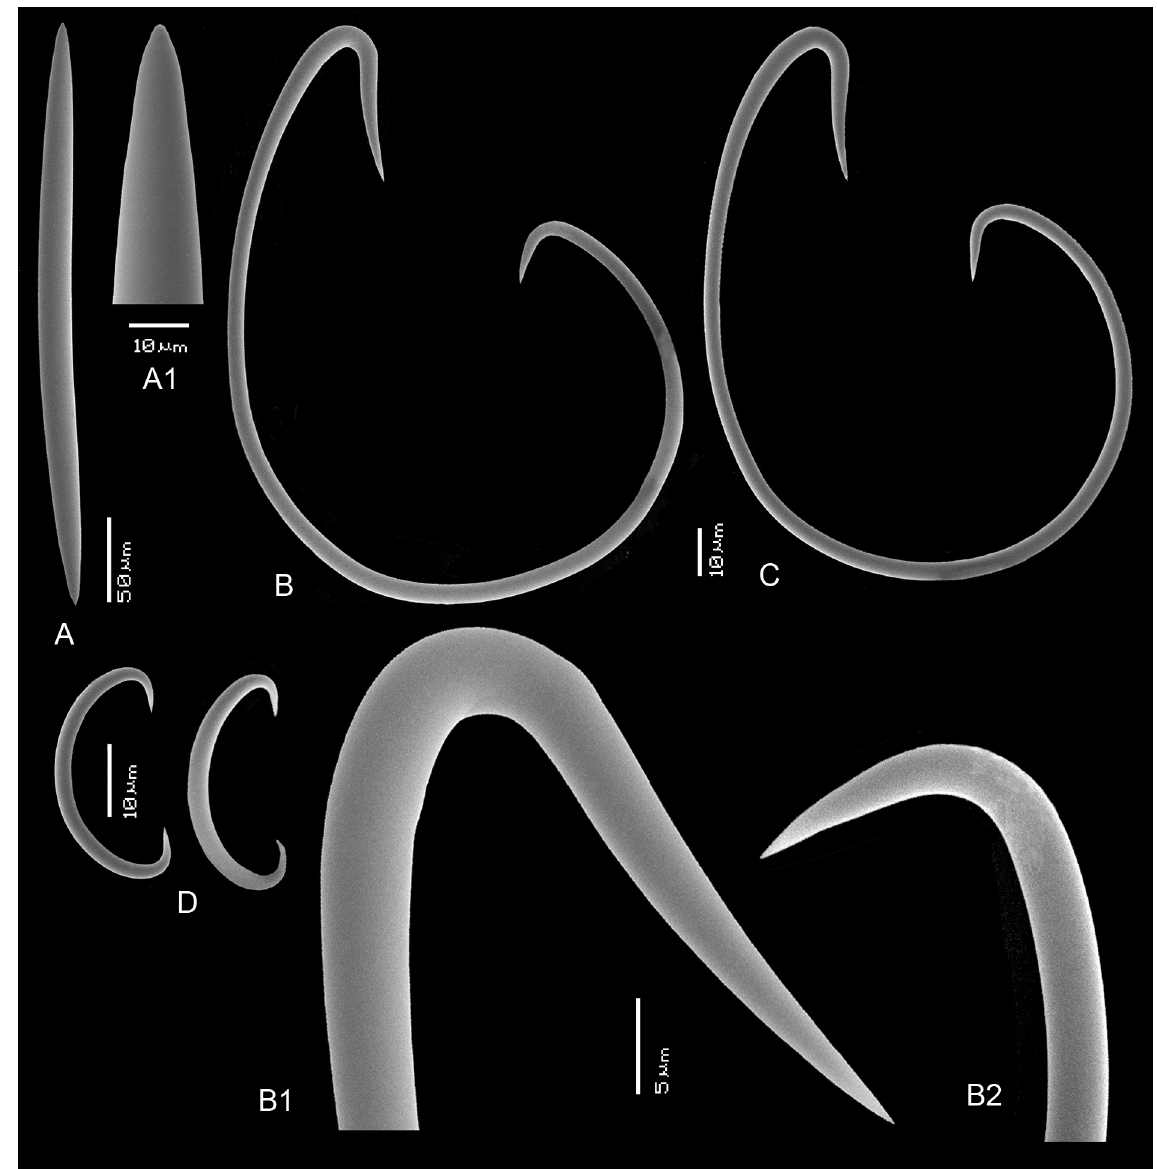
Fig. 8. Haliclona ( Flagellia ) hamata (Thiele, 1903) subgen. et comb. nov., SEM images of spicules (ZMA Por. 09285). A . Oxea. A . Detail of one of the apices. B–C . Flagellosigmas. B 1 ending of flagellosigma. B . Detail of short ending of flagellosigma. D . 2